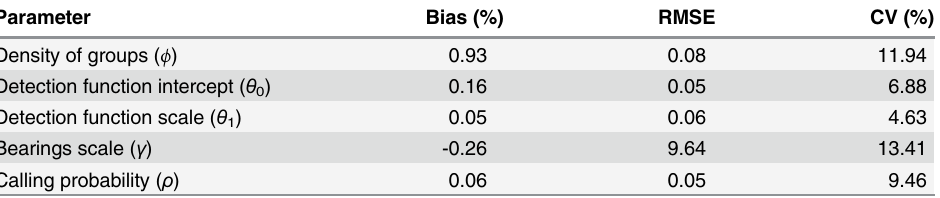
Table 3. Results of the second simulation study. Bias, root mean squared error (RMSE) and coefficient of variation (CV) are shown for all model parameters. Each simulation used three sampling occasions and 13 replicates of a 1 by 4 array, with 1000m spacing between listening posts in each